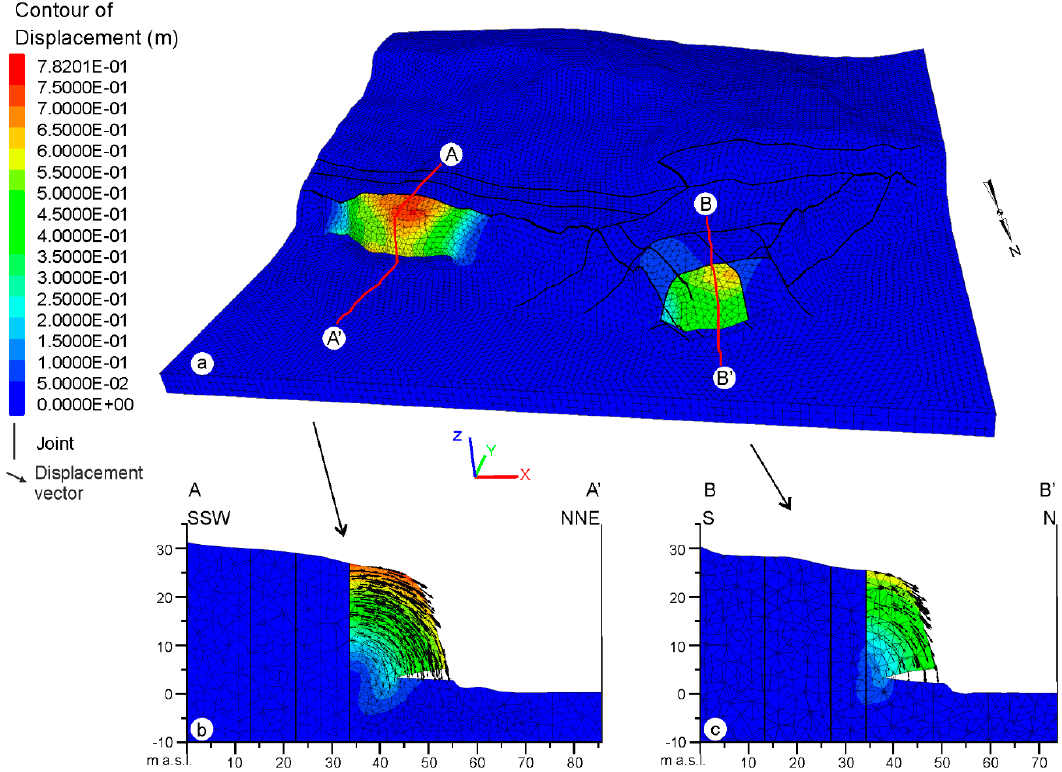
Figure 13. ( a ) The displacement contours and vectors of the Punta Ferruccio cliff; ( b ) the A-A’ section; and ( c ) the B-B’ section.